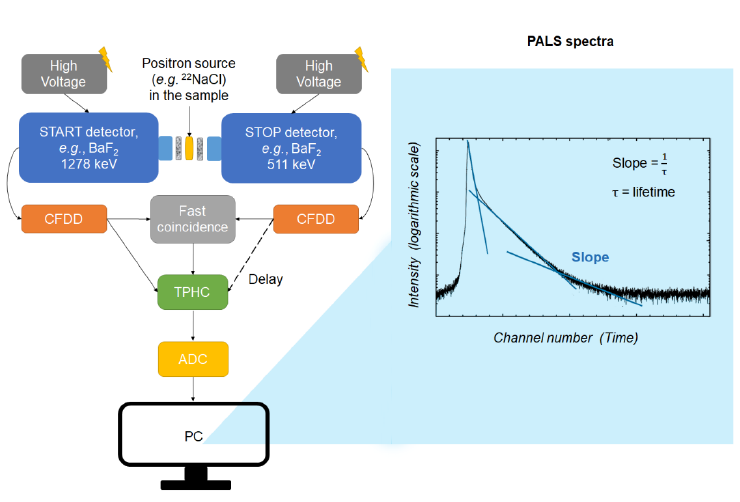
Figure 1. Schematic of the PALS spectrometer and spectra. Abbreviations: ADC = analogue-to-digital converter, CFDD = constant-fraction differential discriminator, TPHC = time-to-pulse height converter, PC = personal computer and special program for experimental data collection and analysis. Notes: The fast coincidence circuit produces the gate signal for the TPHC provided that the coincidence event of gamma rays with proper energies has occurred simultaneously.